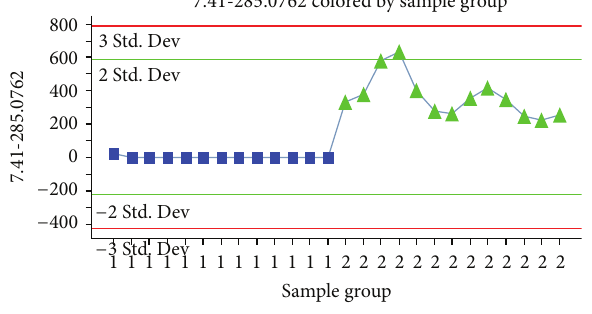
Figure 5: The trend plot of 7.41-285.0762 in positive mode between C group ( ◼ ) and SHLI group ( 󳵳